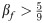
Scatterplot of the bimodality coefficient of the tolerance distribution βf at the end of simulations, against the rate of change of tolerance (Δf).Again, treatments were merged due to their similarity. The critical value βf>59 is denoted by the horizontal red line.